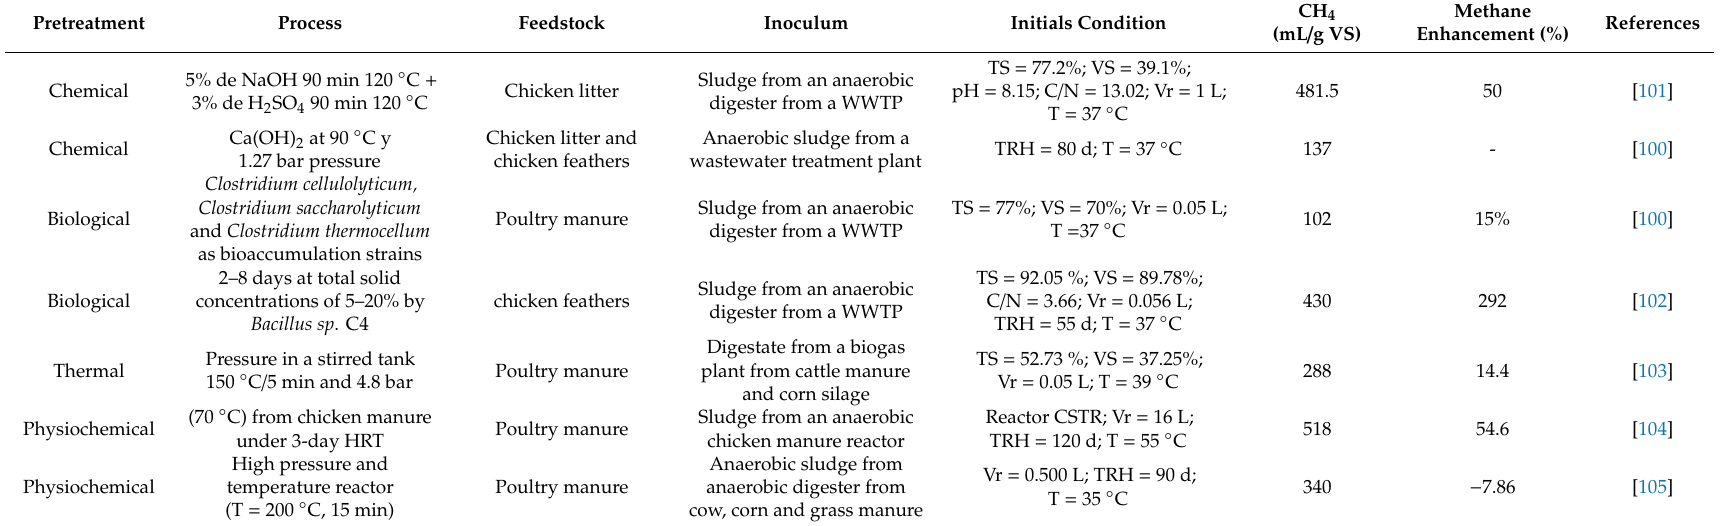
Table 5. E ff ects of the di ff erent pretreatments applied to poultry